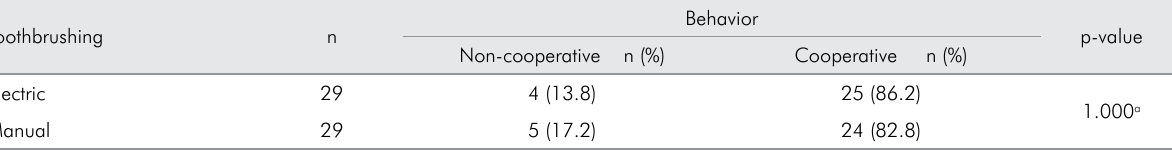
Table 3. Distribution of the sample according to behavioral analysis during use of electric and manual toothbrushes by children and teenagers with Down